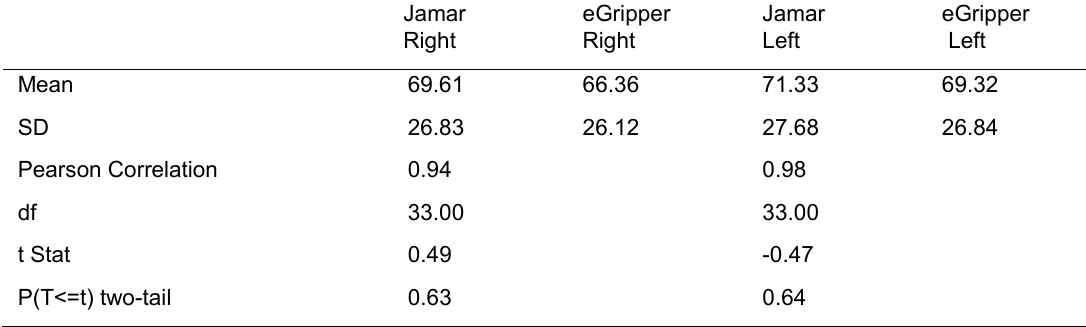
Results of Paired t-Tests between eGripper and Jamar Dynamometers